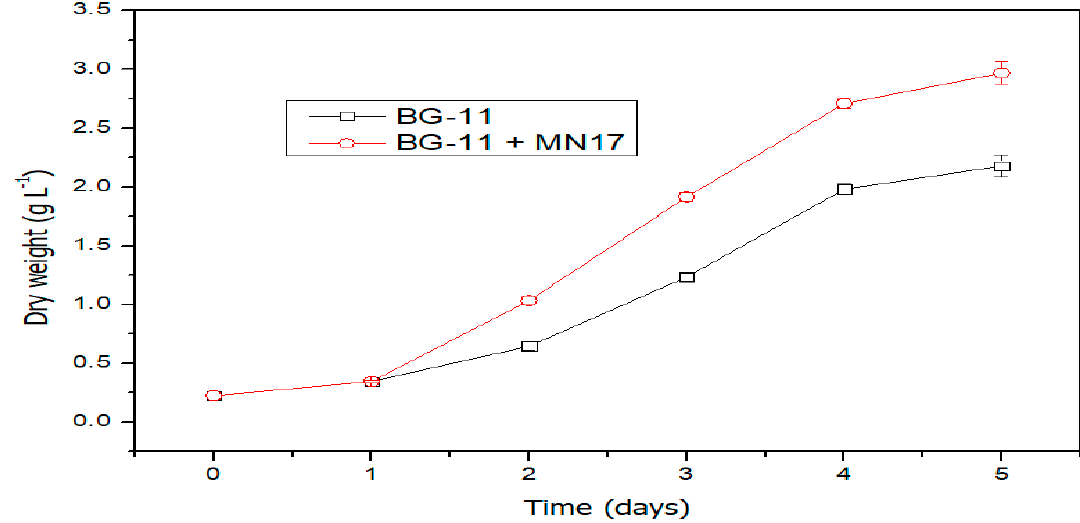
Figure 1. Biomass changes of Chlorella vulgaris and C. vulgaris–Enterobacter sp. MN17 consortium in BG-11 media.